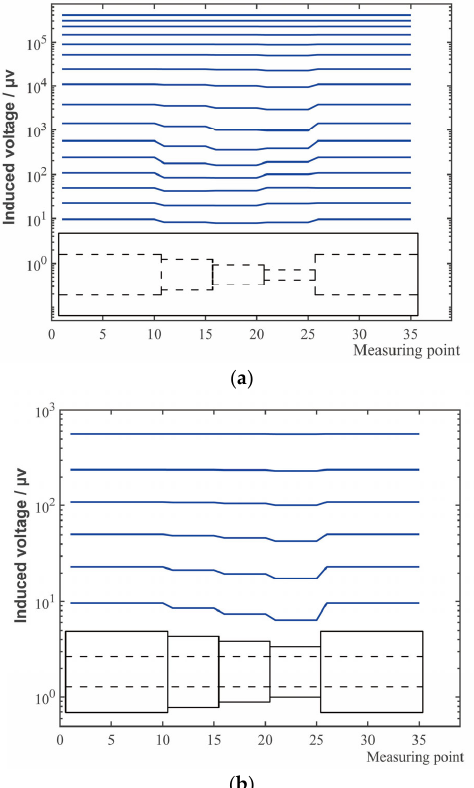
Figure 9. Time slices of voltage of receiving coil in the simulated inspection of tubing plus casing: ( a ) Corroded tubing plus undamaged casing; ( b ) Undamaged tubing plus corroded casing.